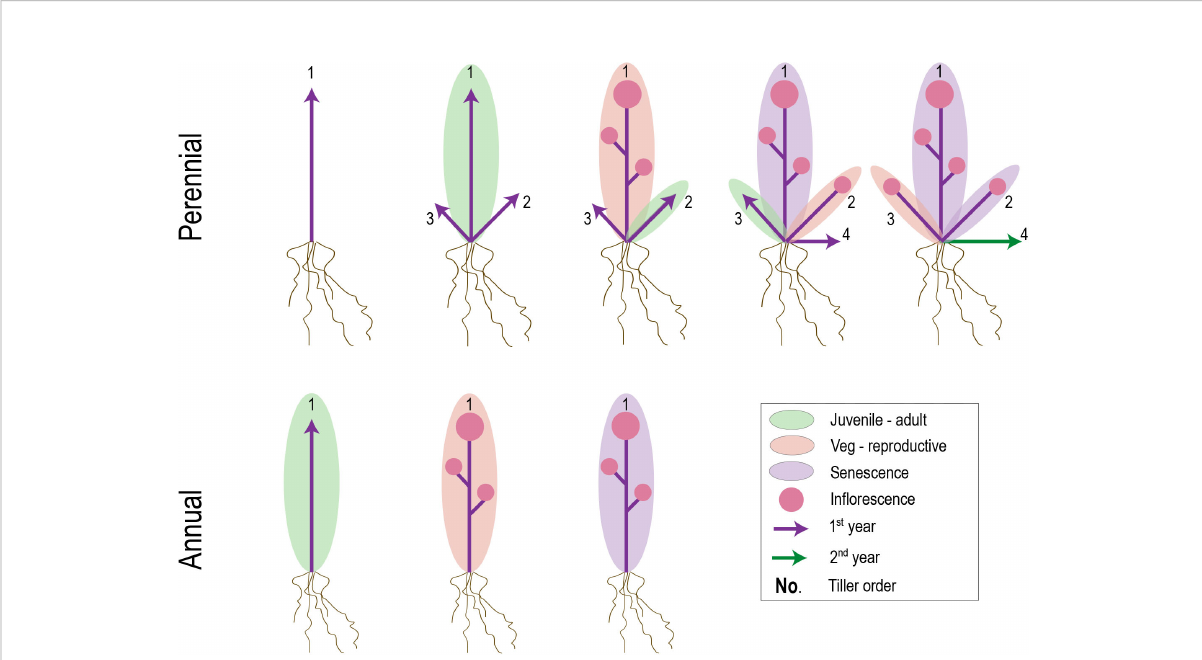
FIGURE 4 Hypothetical fi gure suggesting common mechanisms underlying transitions between perennial and annual life histories. Evidence from at least some plant groups with mixed perennial and annual habits suggests heterochronic shifts in juvenile-adult (green ellipse) and/or vegetative- reproductive (yellow ellipse) phase transitions. Relatively later transitions in perennial plants, combined with a potentially larger root to shoot system, might allow increased shoot meristem development and/or outgrowth prior to fi rst fl owering. If phase transitions and senescence occur successively on individual branches (labeled 1-4), late-developing branches in perennials that are juvenile upon the fi rst waves of senescence might be preserved in that state until the next growing